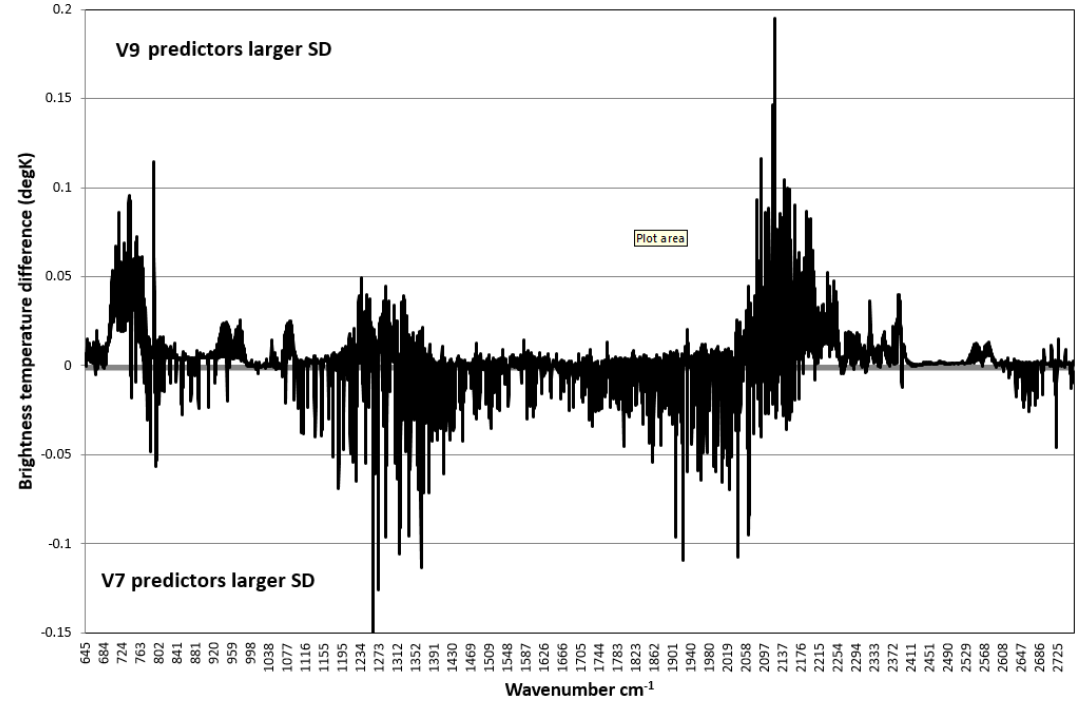
Figure 3. For selected IASI channels, the difference of the standard deviations of the brightness temperature fit between the LBLRTM line- by-line channel-integrated optical depth model and RTTOVv12-computed optical depths for the 83-profile dependent set for all views up to 63 ◦ with version 7 and version 9 predictors. Version 7 predictors have smaller differences for positive values, and version 9 predictors have smaller differences for negative values. Note that the version 9 predictors are also computing the optical depths of the trace gases whereas for version 7 only water vapour and ozone are